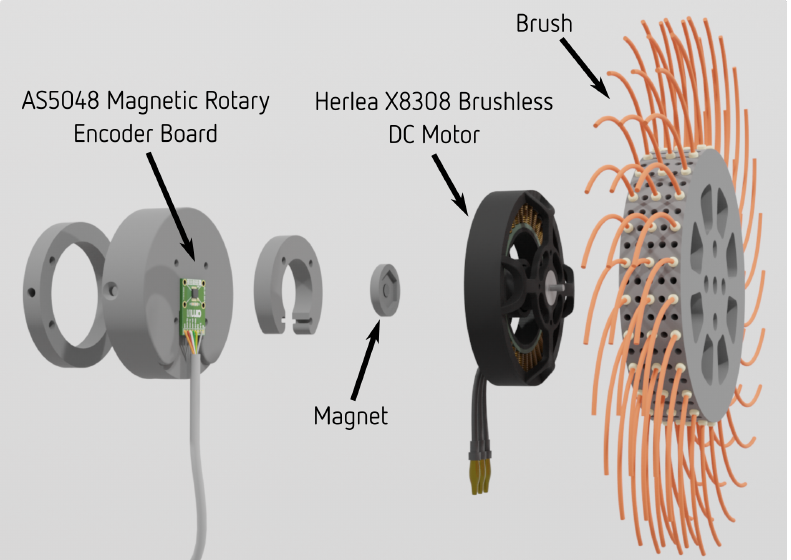
Figure 3. Exploded view of the direct drive brush-shaped tool developed for vine suckering. The tool is actuated by a torque-dense brushless DC